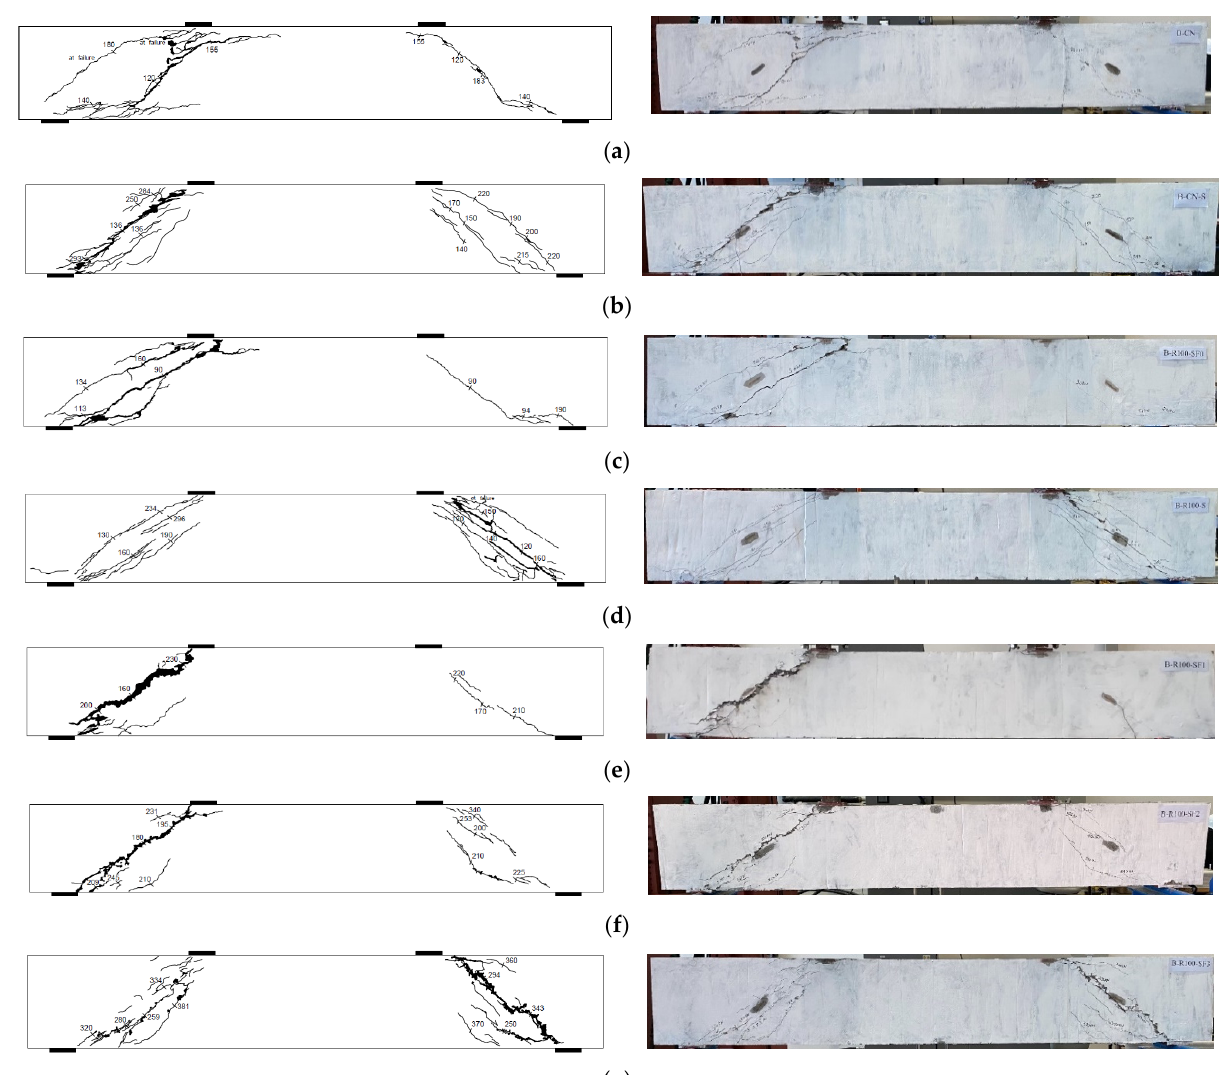
Figure 5. Crack pattern at failure: ( a ) BR0-SF0; ( b ) BR0-SF0-S; ( c ) BR100-SF0; ( d ) BR100-SF0-S; ( e ) BR100-SF1; ( f ) BR100-SF2; and ( g ) BR100-SF3.